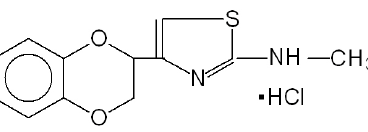
Figure 1. Chemical structure of 2-(2-methyl-amino-thiozolyl)-1,4-benzodioxane hydrochloride (mesedin) containing five-membered heterocycle with two heteroatoms (nitrogen and sulfur) in the second position.